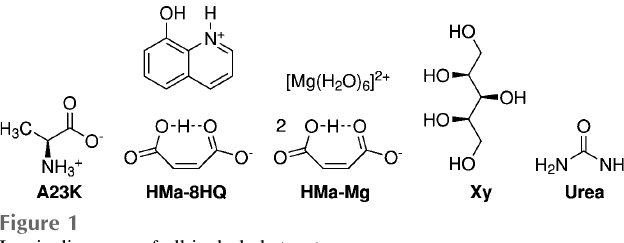
Figure 1 Lewis diagrams of all included